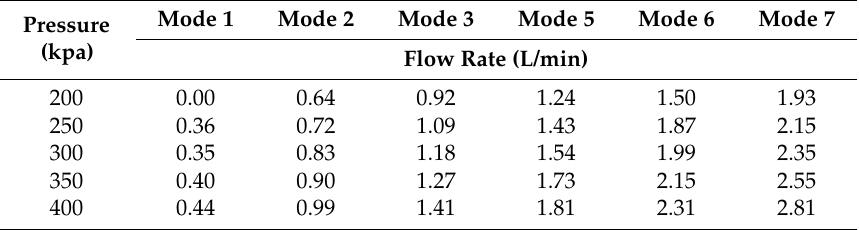
Table 4. Instantaneous flow rate of six spraying modes in different